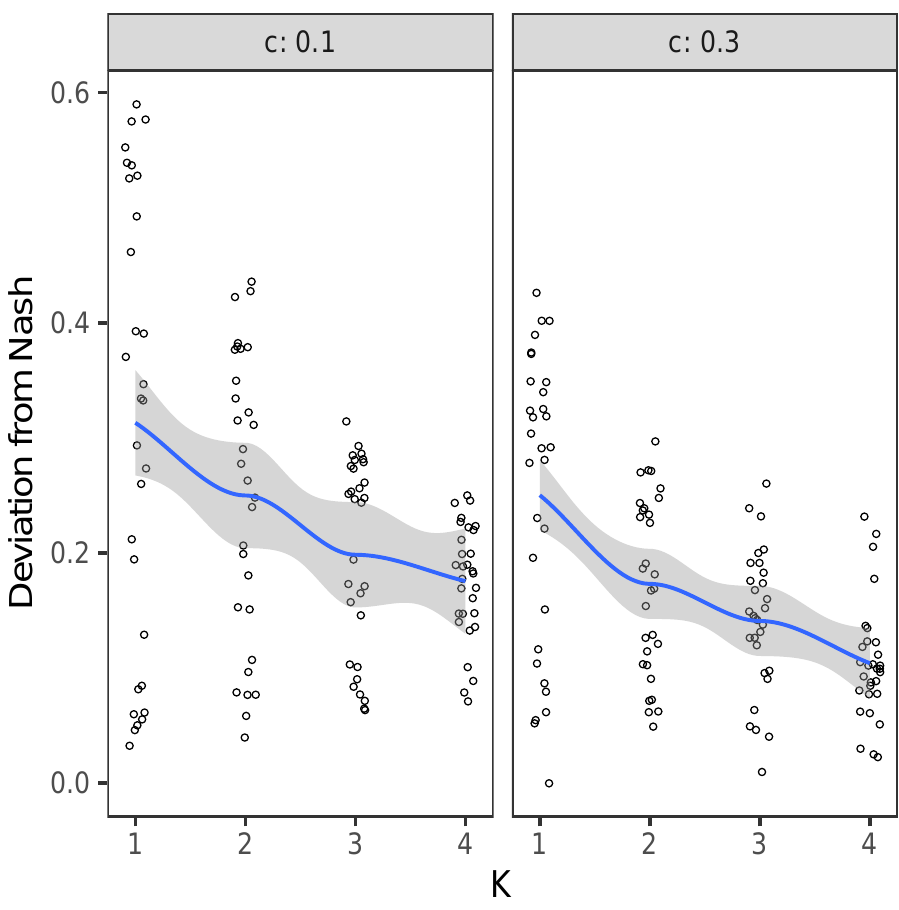
Figure 8 – Root mean squared deviation (RMSD) from the Nash equilibrium, as a function of K and c . The mean squared deviation (MSD) of a strategy is calculated by numerically integrating the squared difference between its density function and that of the NE. The MSD of an entire simulation is the average of MSD across strategies and generations, excluding the first 1000 generations. The RMSD (plotted above) is the square root of the MSD of the simulation. Each point is a simulation of 5000